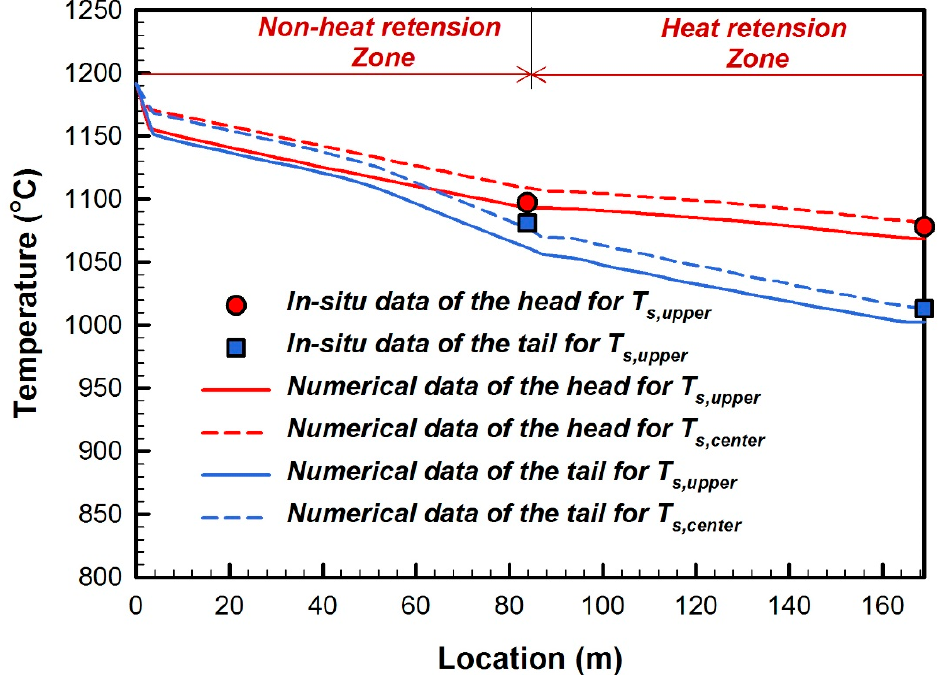
Figure 8. Comparison of the numerical data with the in-situ data for the upper surface and centerline-surface of the transfer bar with the traditional passive heat retention panel. 249